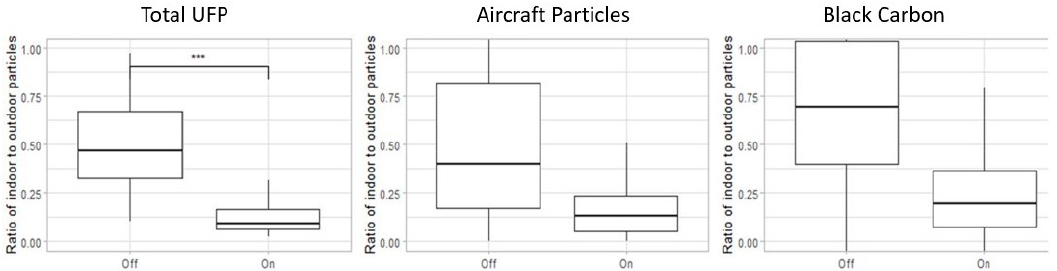
Figure 5. Infiltration ratio of different particle types before and after the portable HEPA filter intervention. This data represents the range of indoor/outdoor ratio of pollutants across all five schools. In the boxplots, the upper whisker represents the maximum, the top of the box represents the 75th percentile, the middle line represents the median or 50th percentile, the bottom of the box presents the 25th percentile, and the lower whisker represents the minimum. A two-sample Wilcoxon Rank Sum test confirms that the infiltration before the HEPA filter intervention is significantly higher than after the intervention ( p < 0.5), for each of the three particle sources. *** indicates the results are statistically significant.